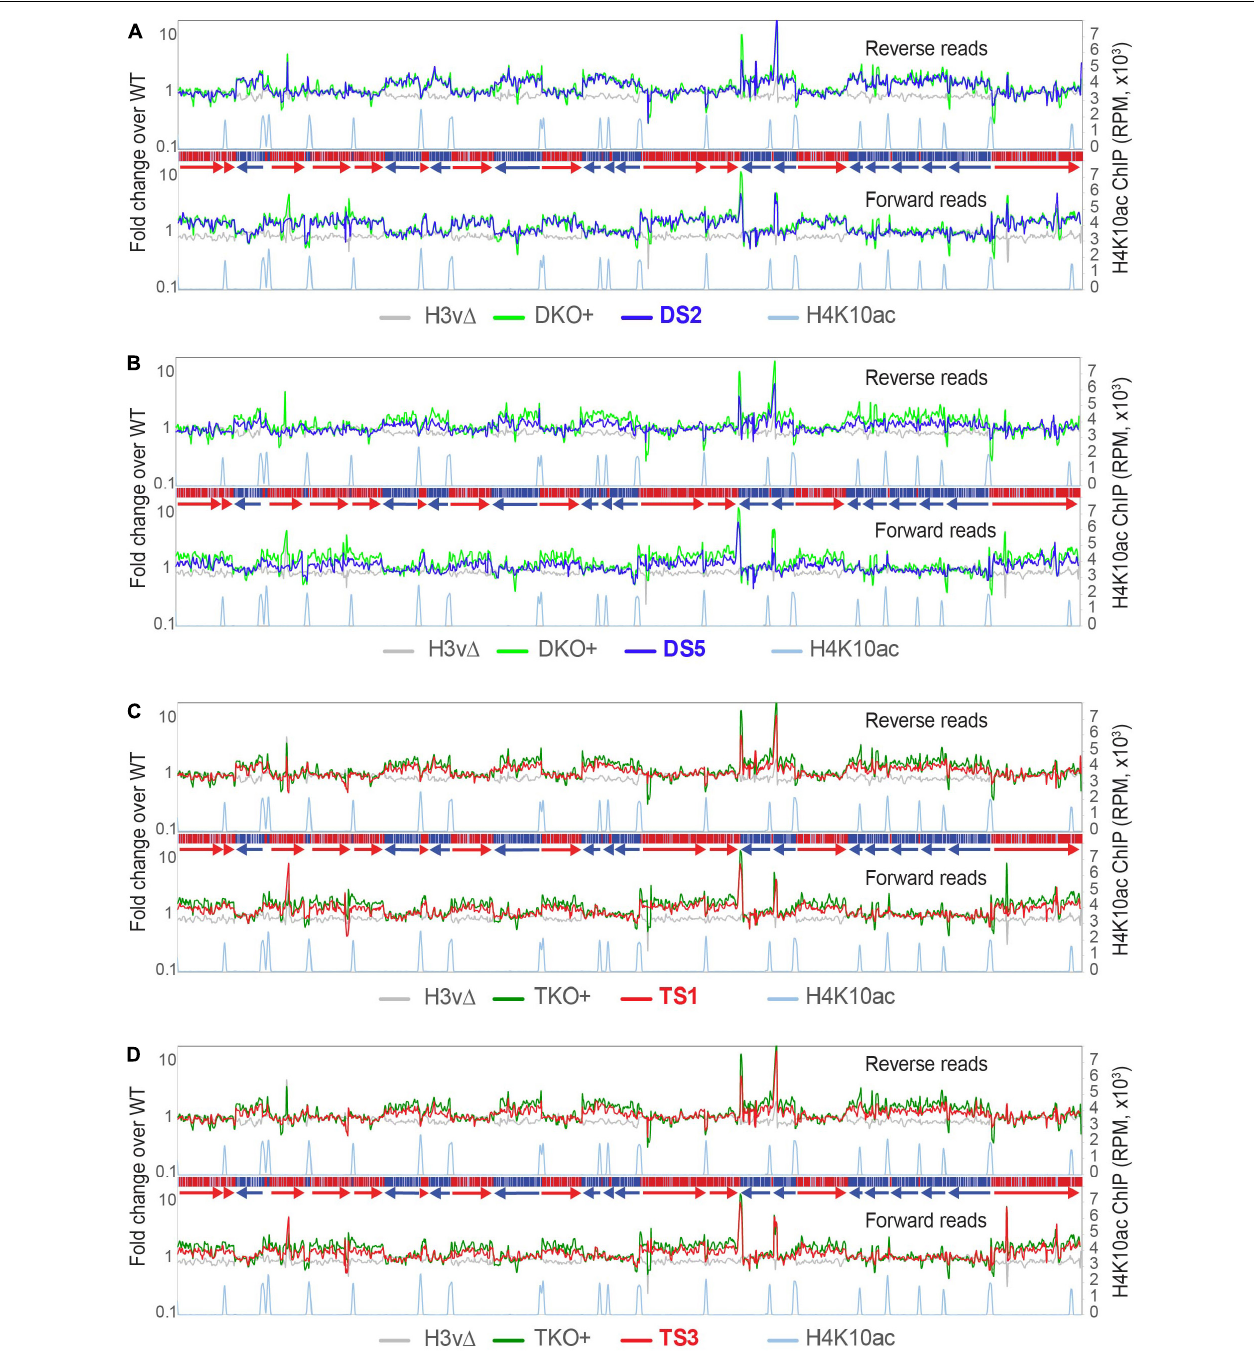
FIGURE 7 | Emergence of survivors after the removal of H3v in DKO and TKO mutants: transcription phenotypes. Global transcription and antisense transcription were examined in three DS and three TS clones by rRNA-depleted stranded RNA-seq (10-kb bin, 2.5-kb step). Fold changes compared to WT were plotted and compared with Tet-treated DKO or TKO mutant. Two DS (DS2 and DS5) and two TS (TS1 and TS3) clones are